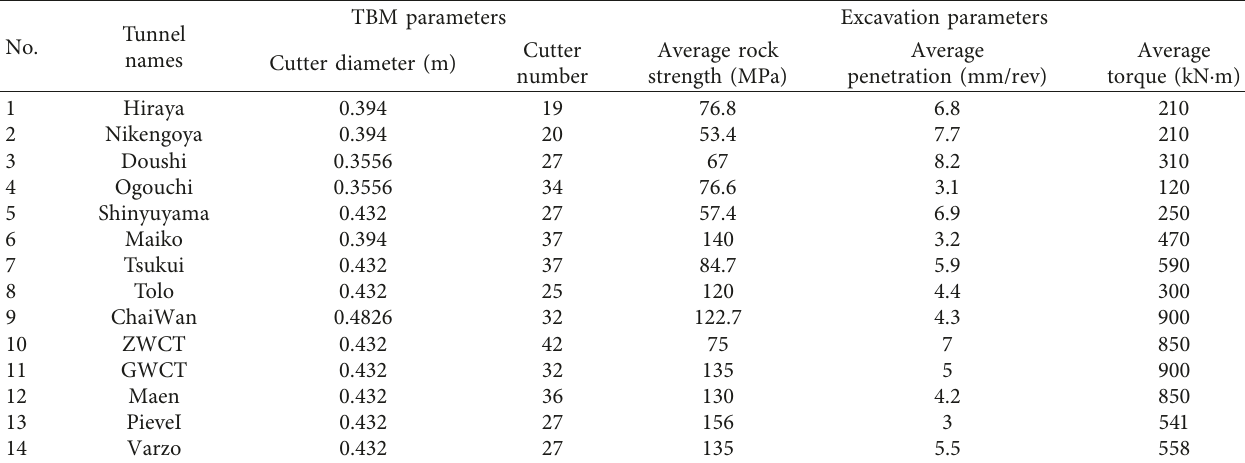
Table 2: Driving data and specification parameters from 14 TBM